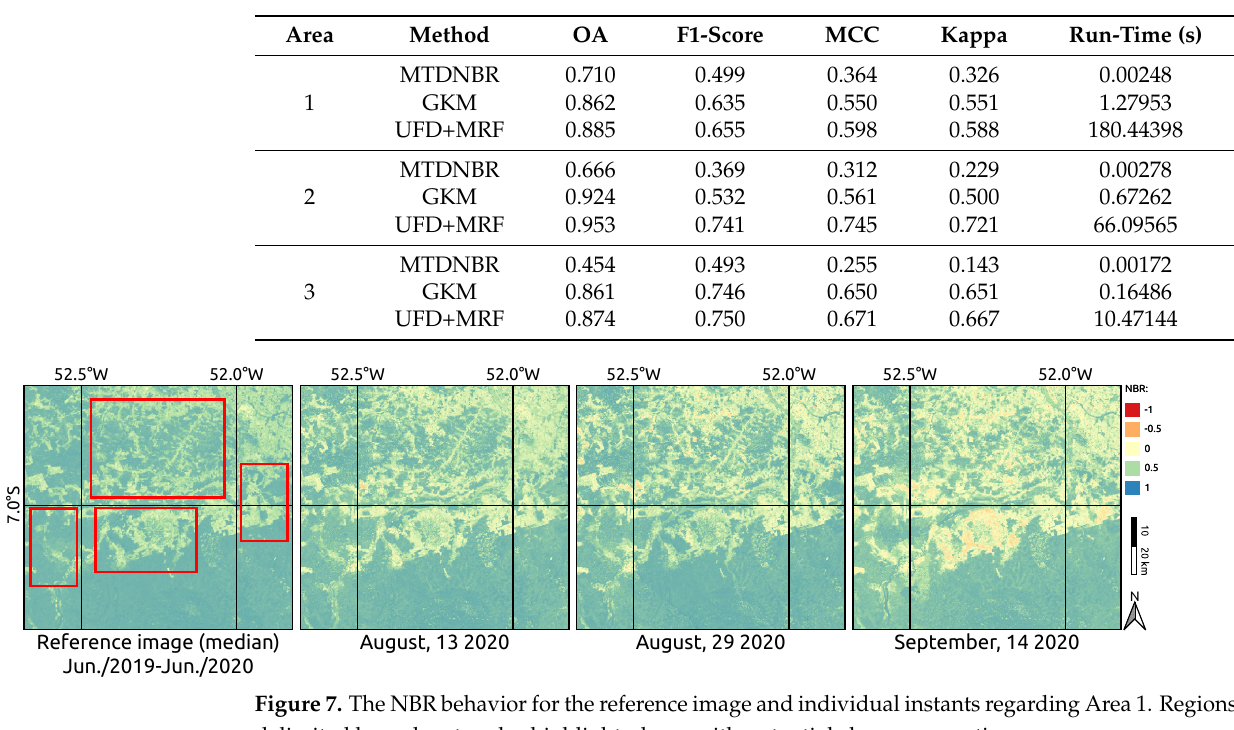
Table 3. Accuracy values summary.